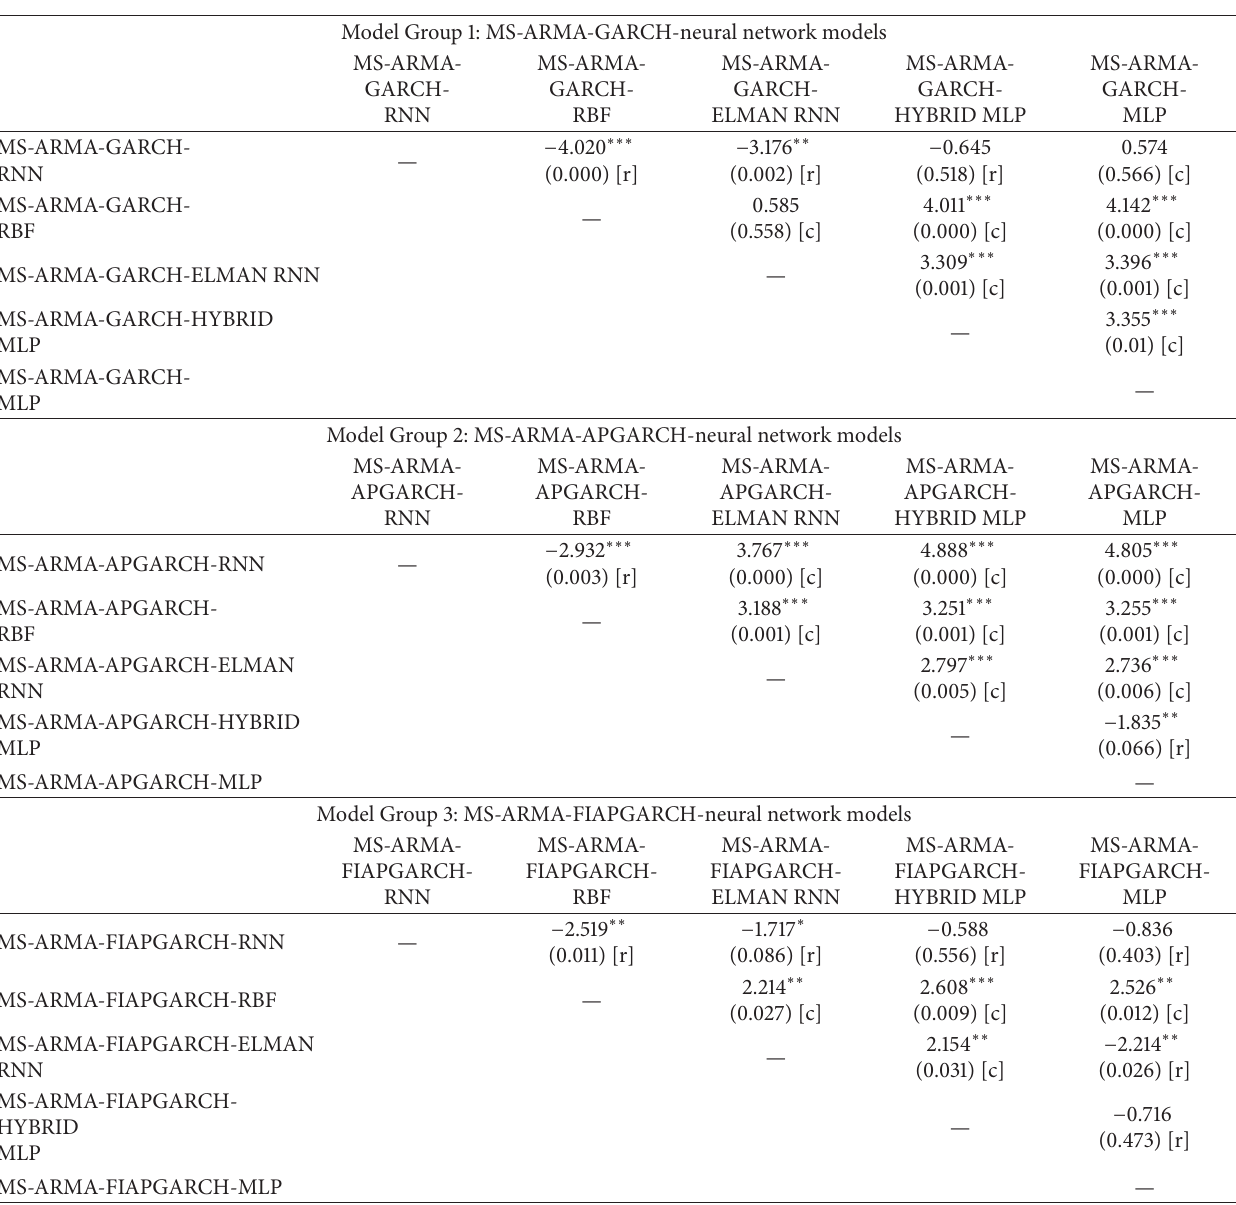
Table 7: Diebold Mariano equal forecast accuracy test results, out of